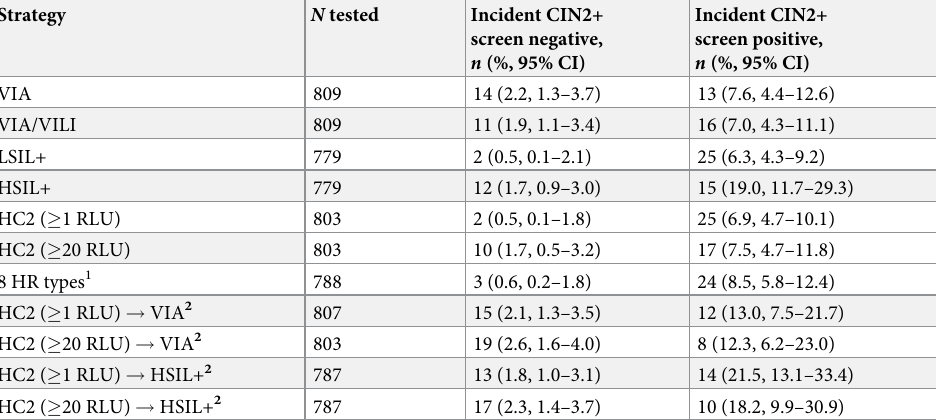
Table 4. CIN2+ incidence at endline among baseline screen-negative women (countries combined). Strategy N